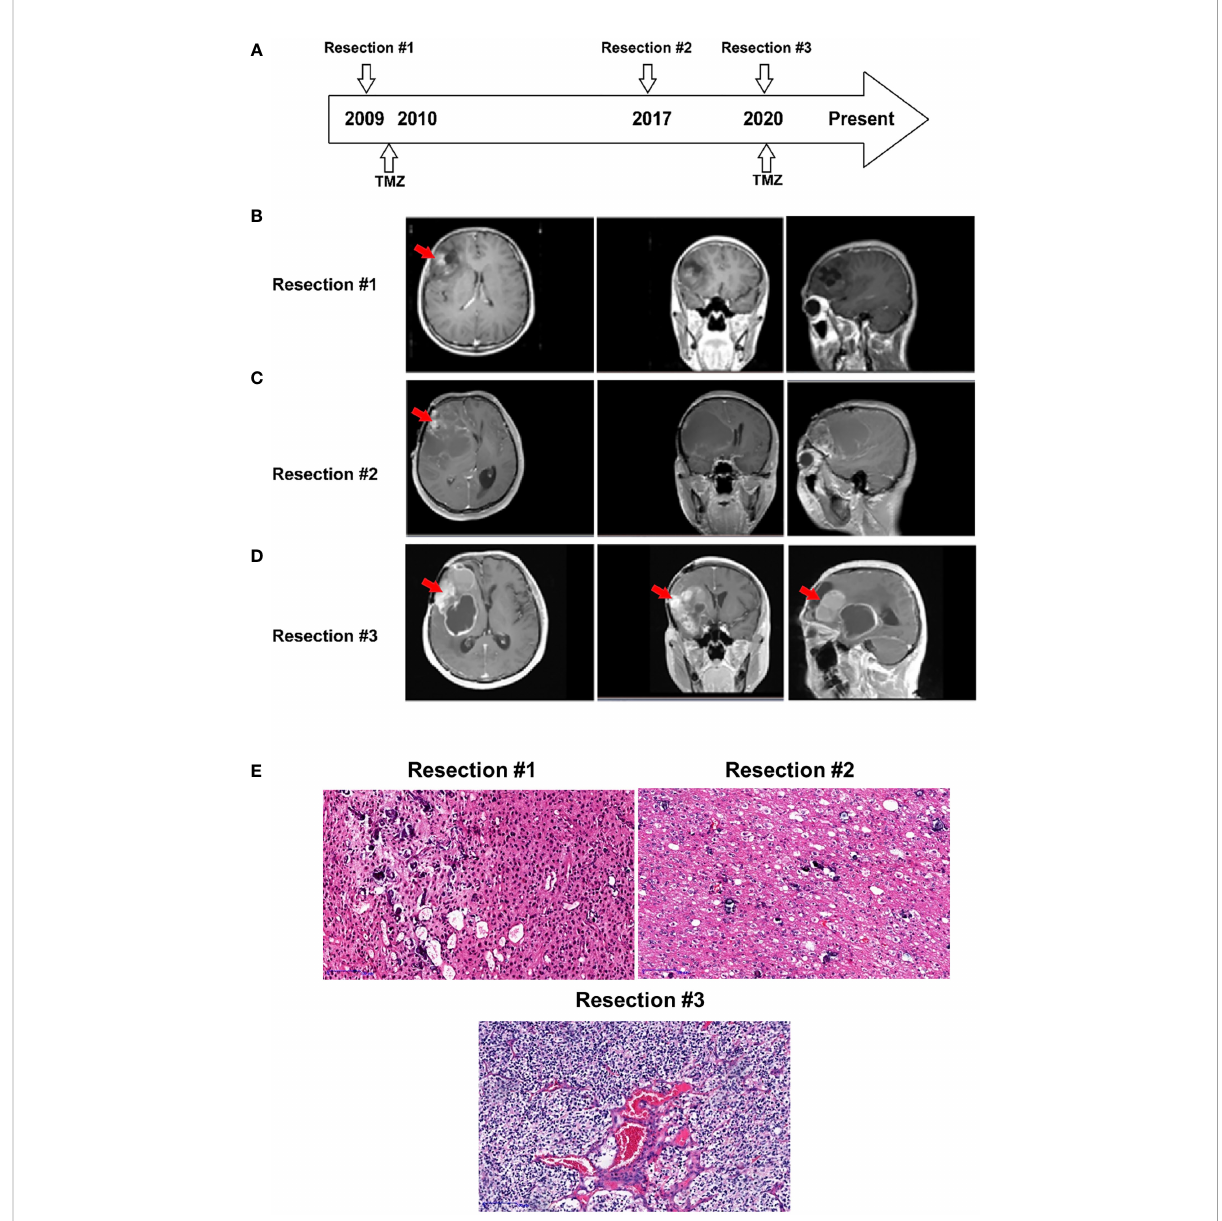
FIGURE 1 Case presentation. (A) Timeline of disease diagnosis and treatment. (B – D) Magnetic resonance imaging (MRI) obtained during three resections. The red arrows indicate the tumor locations. (E) Slides of resected tissue collected from the same patient at three timepoints in the disease course were subjected to HE staining